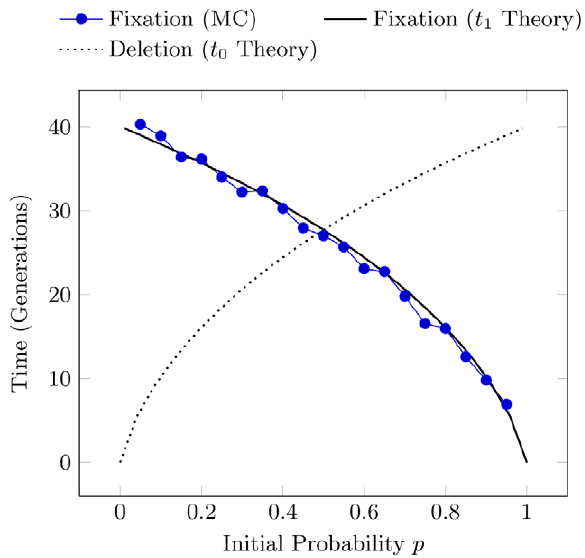
Figure 1. Time to fixation for a population of N ~ 10 individuals (sample size 2 N ~ 20 ) plotted as a function of initial allele probability p under the Monte Carlo (MC) sampling regime and as given by theoretical prediction (solid line) of Eq. (4). Time to deletion is also shown (dashed line), Eq. (5).